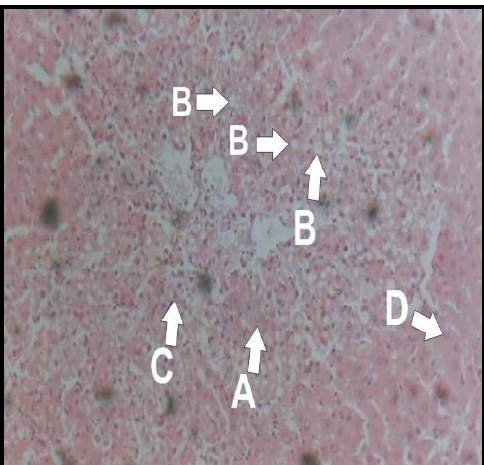
Figure( 3): Section of rat's liver showing the effect of pre-treatment with 25mg.kg -1 .day 1 PTX for 14 days prior to CCl -A: Necrotic damage. -B: Steatosis. -C: Inflammatory cell infiltration -D: Normal hepatocyte. Magnification: (10*10); staining: Haematoxylline and Eosin.